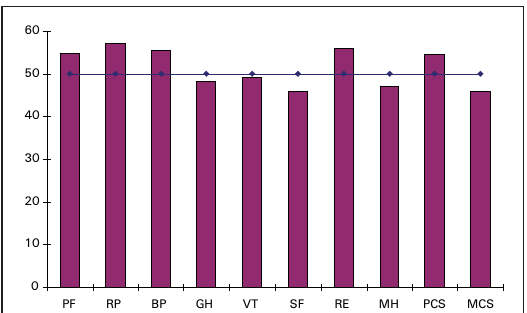
Quality of life after IPAA – SF-36